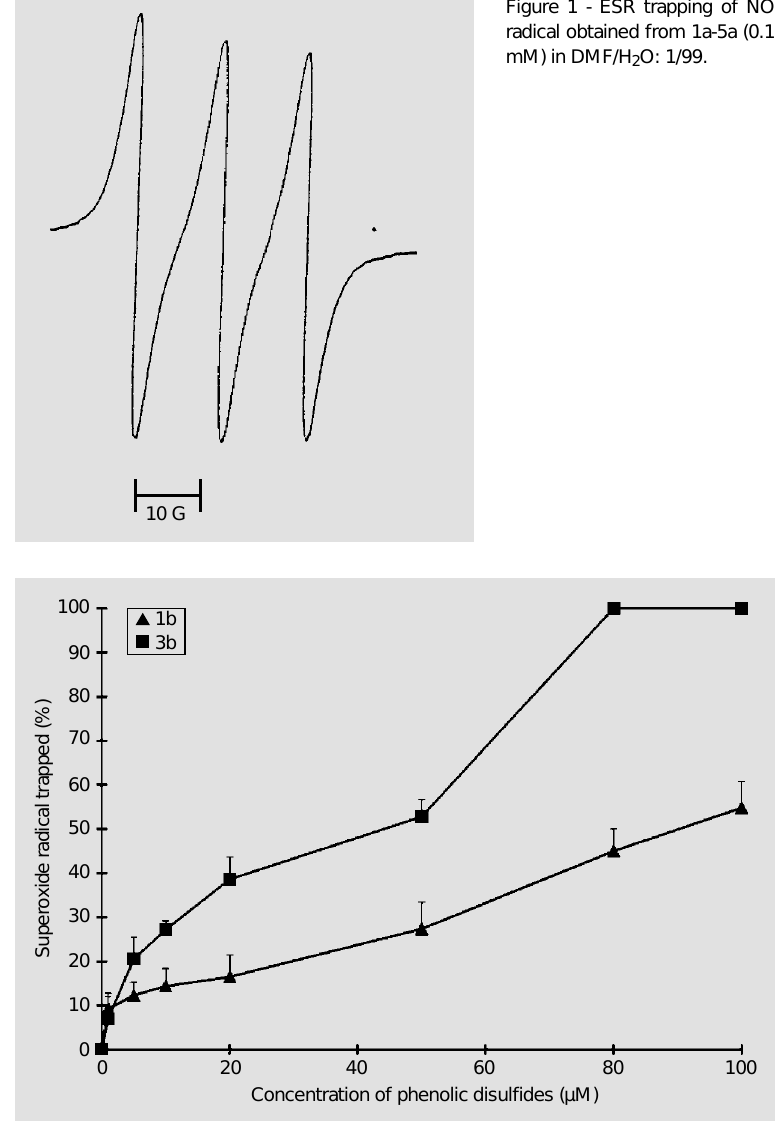
Figure 2 - Inhibition of cytochrome c reduction by disulfides 1b and 3b (1-100 µM) in 50 mM phosphate buffer, pH =